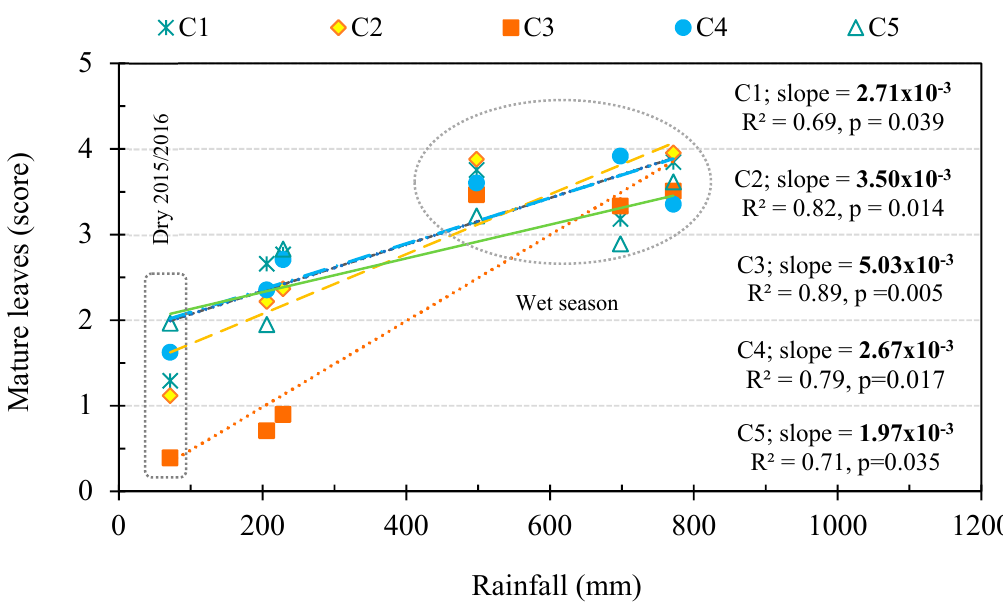
Figure 5. Relationships between rainfall and mature leaves as a proxy for the degree of deciduousness of five clusters (C1–C5) during the three dry and three wet seasons from 2015 to 2018. Slope indicates the phenological sensitivity (degree of deciduousness) of the cluster in response to water availability, the data points in the circles indicate the mature leave scores during wet season, those outside the circle are the mature leaves scores during the dry season, and the data points in the dashed box are mature leaves scores during the dry season 2015/2016 (during El Niño).